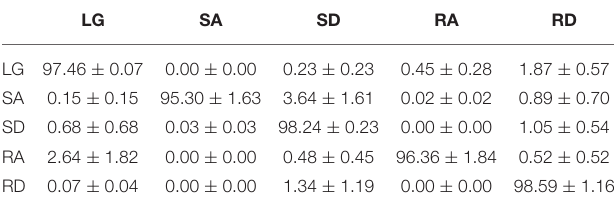
TABLE 3 | Recognition confusion matrix (mean ± SEM) based on QDA